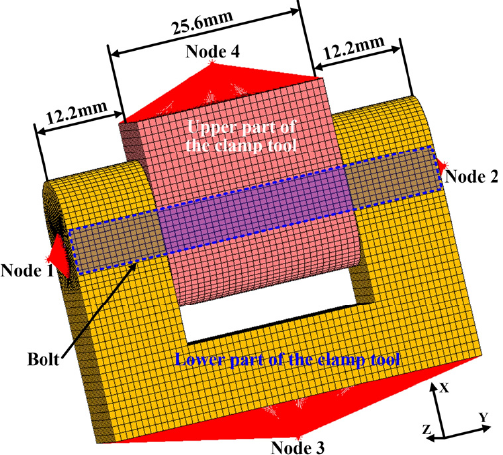
Figure 8. Boundary conditions of finite element model of the bolt and clamp tool.